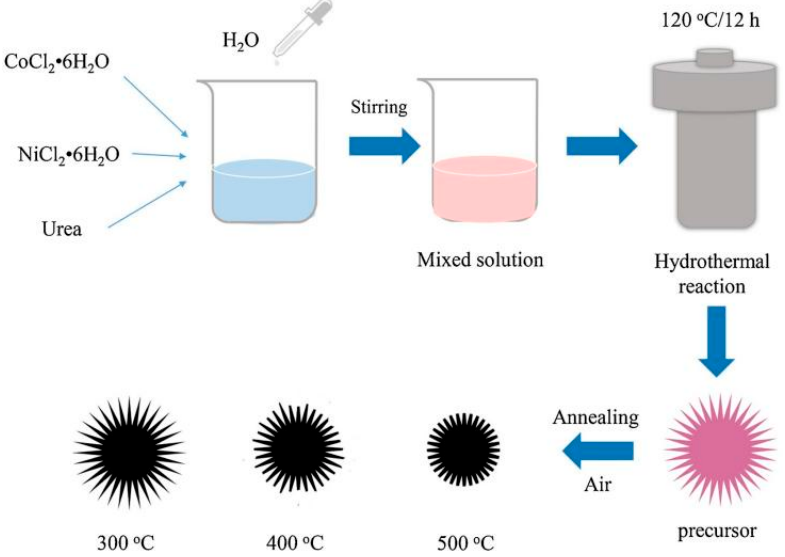
Figure 24. The synthesis process of NiCo 2 O 4 nanospheres annealed at various temperatures [151]. The comparison of gas-sensing characteristics of nanomaterials listed in this paper will be given in Table 3 at the end of this section. Table 3. The gas-sensing properties of various